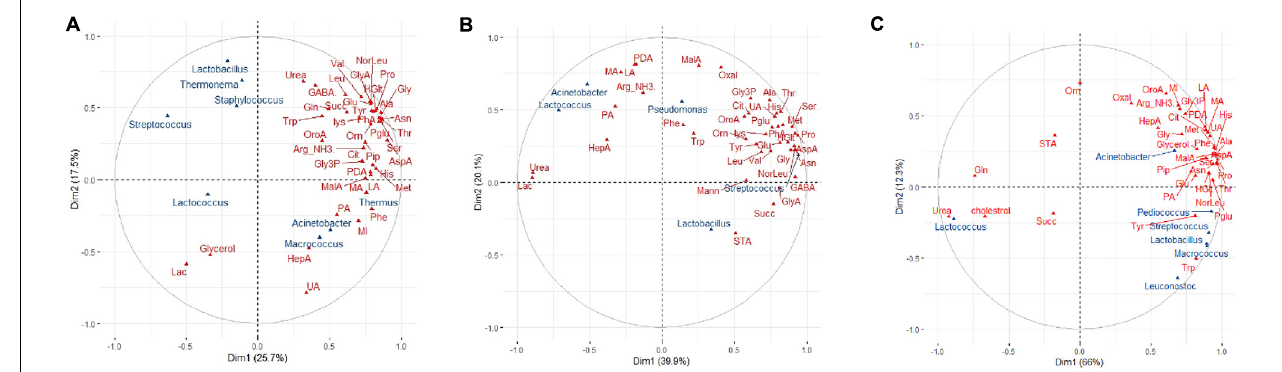
FIGURE 5 | Multifactorial analysis (MFA) showing correlations between bacterial genera and metabolites in cheese. The Correlation circle depicts correlations in normalized abundance between cheese, bacterial genera (blue) and cheese metabolites (red) along the MFA axes for (A) brand A, (B) brand B, and (C) brand C cheeses. Those metabolites and genera which are depicted together in the same direction along an axis indicate positive correlations; those which are depicted together in the opposite direction indicate negative correlations; metabolites and genera depicted in different directions indicate no correlations. The strength of the correlation is shown by the increasing distance from the center of the plot. To improve the readability of the plots, only the greatest correlations for metabolites in each dimension are shown.